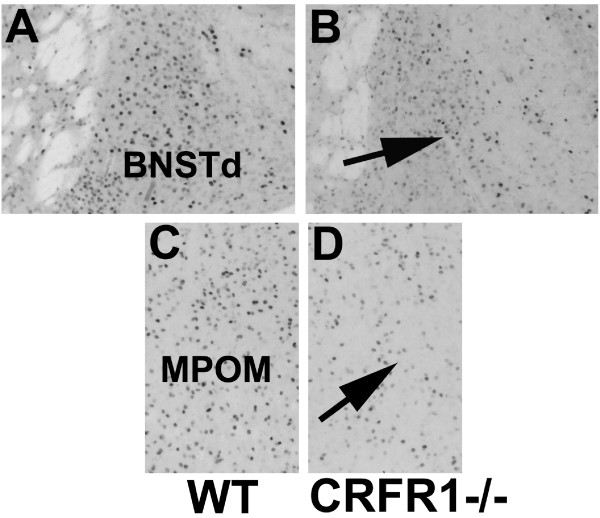
Examples of c-Fos immunoreactivity in BNSTd for WT (A) and CRFR1-/- (B) mice. Examples of Egr-1 immunoreactivity in MPOM in WT (C) and CRFR1-/- (D) mice.